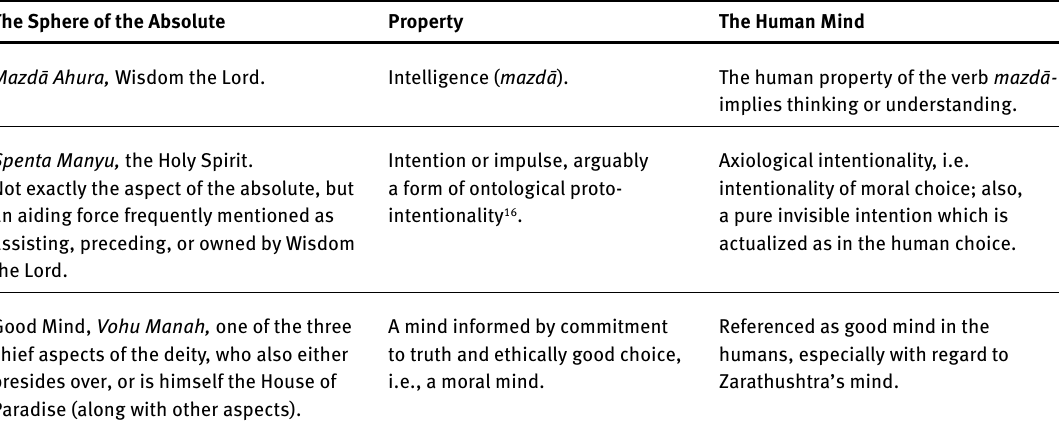
Table 1. Human-Divine Sharing of the